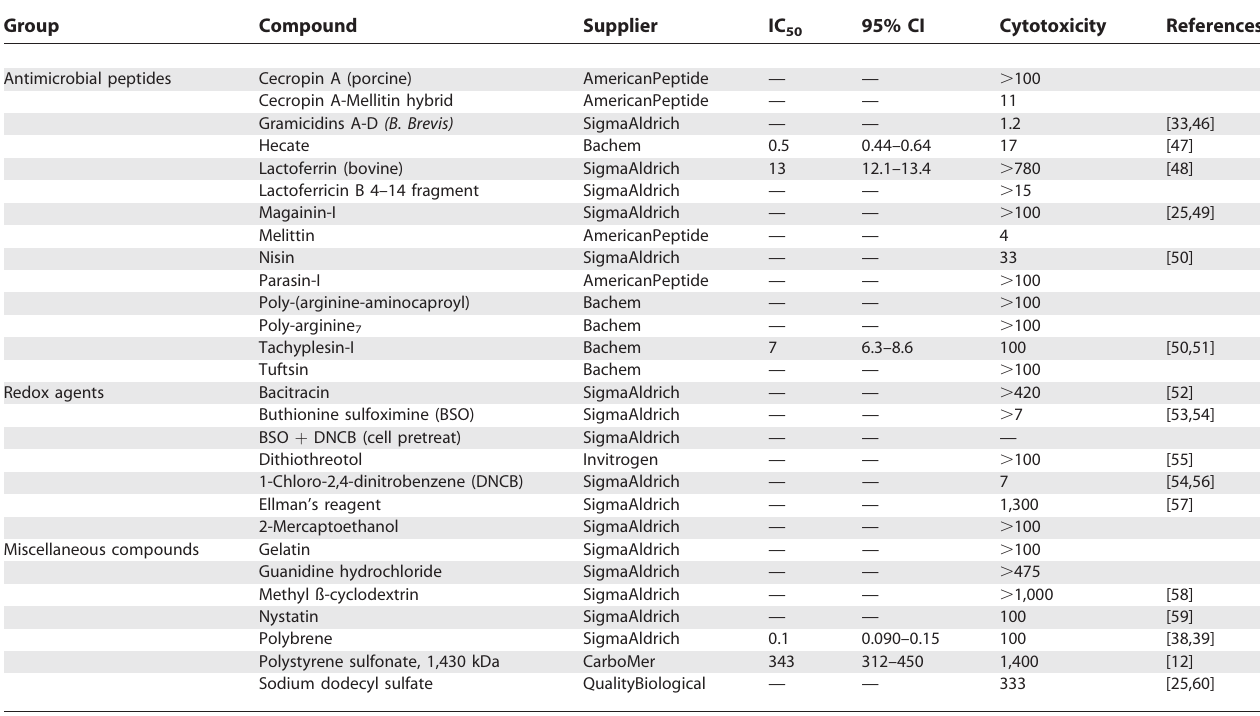
Table 1. Inhibitory Effects of Nonpolysaccharide Compounds